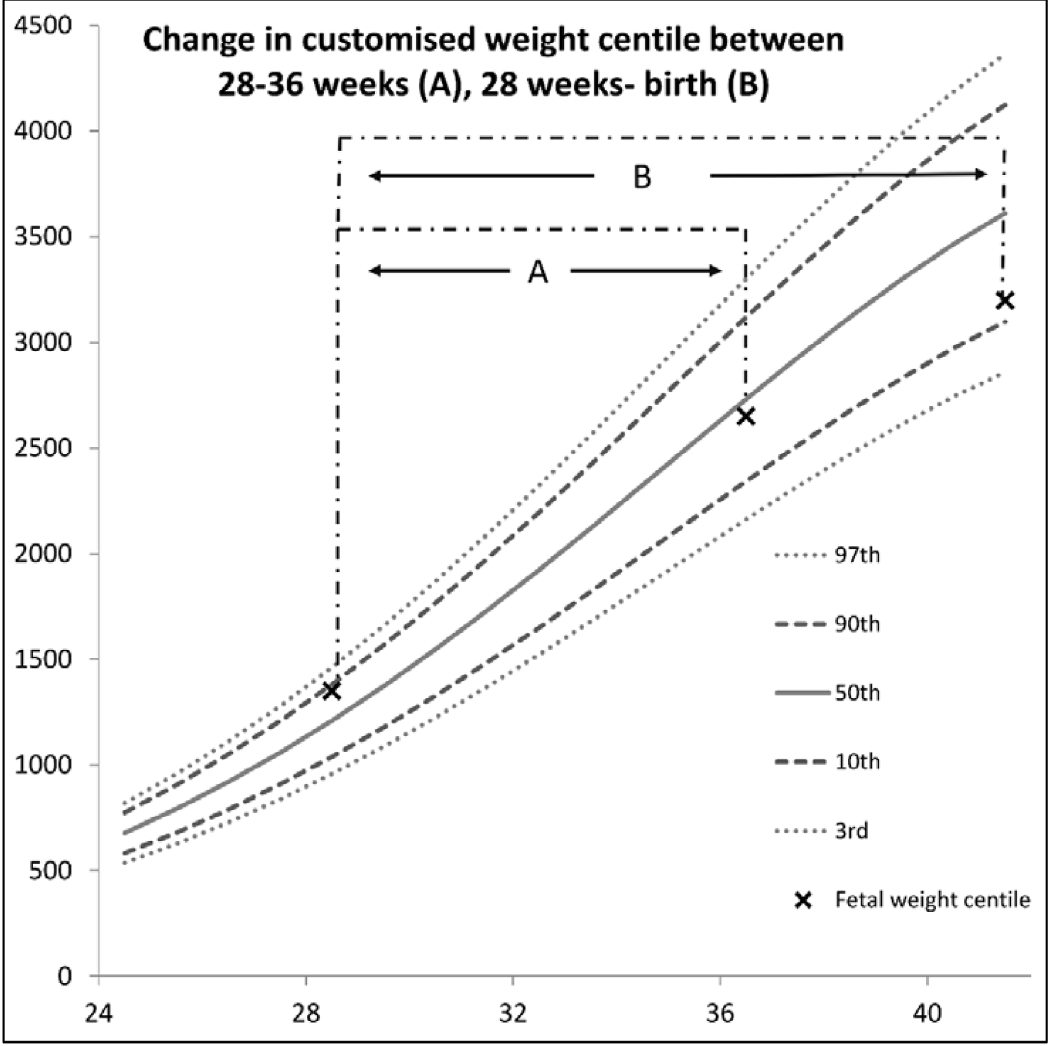
Fig 1. The change in customised centile between 28 weeks and 36 weeks (A) and 28 weeks and birth (B) was calculated as the later fetal weight centile minus the earlier fetal weight centile. A fetus slowing in growth will thus have a negative number to describe their weight centile change; a fetus that maintains growth will have a change of zero , and a fetus with an increase in growth will have a positive number to describe weight centile